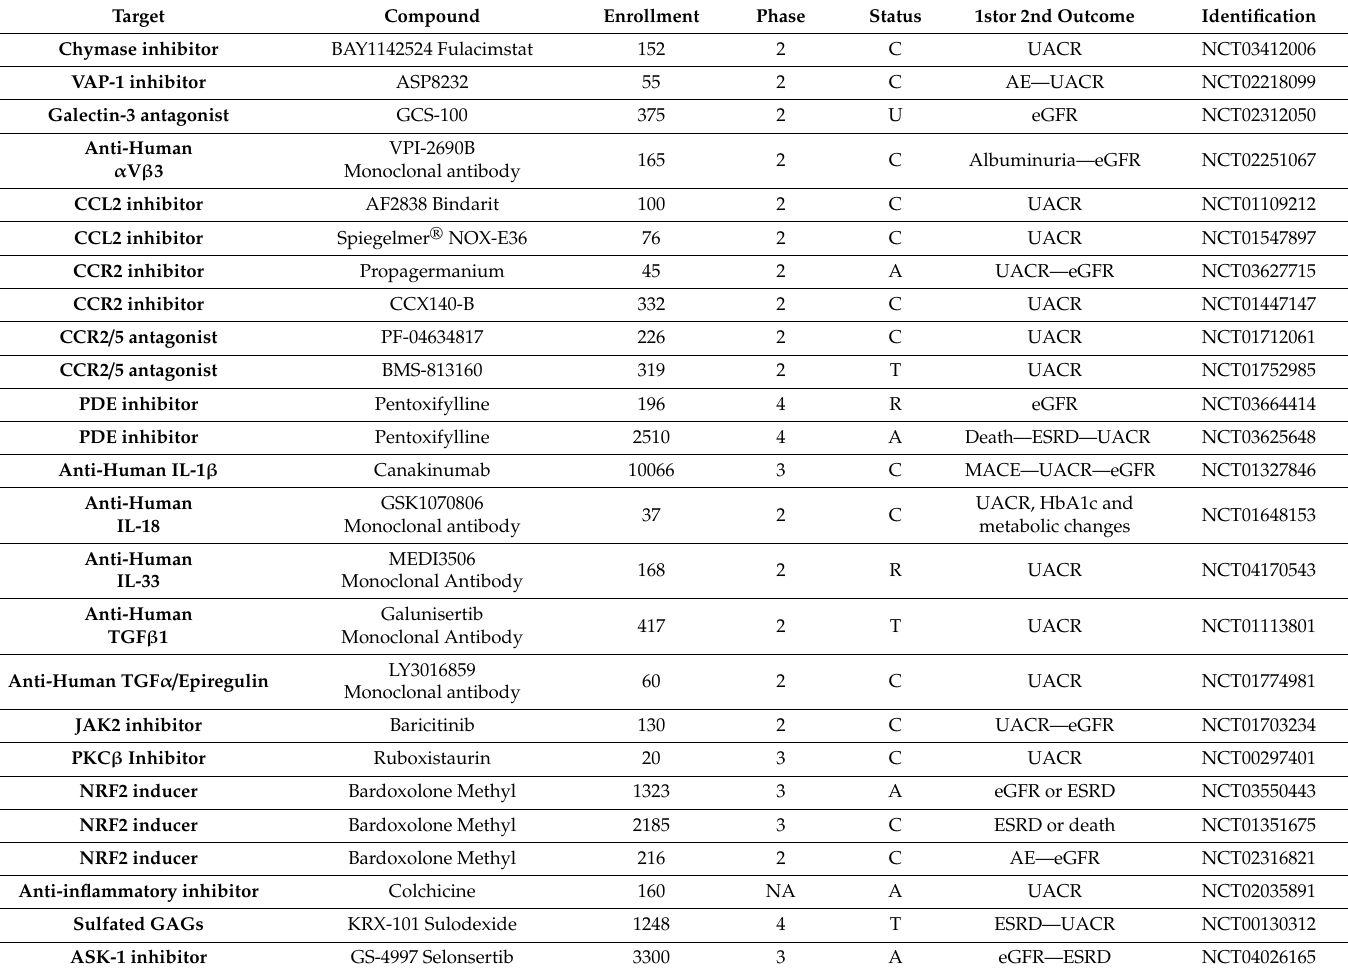
Table 3. Selected clinical trials targeting inflammation in